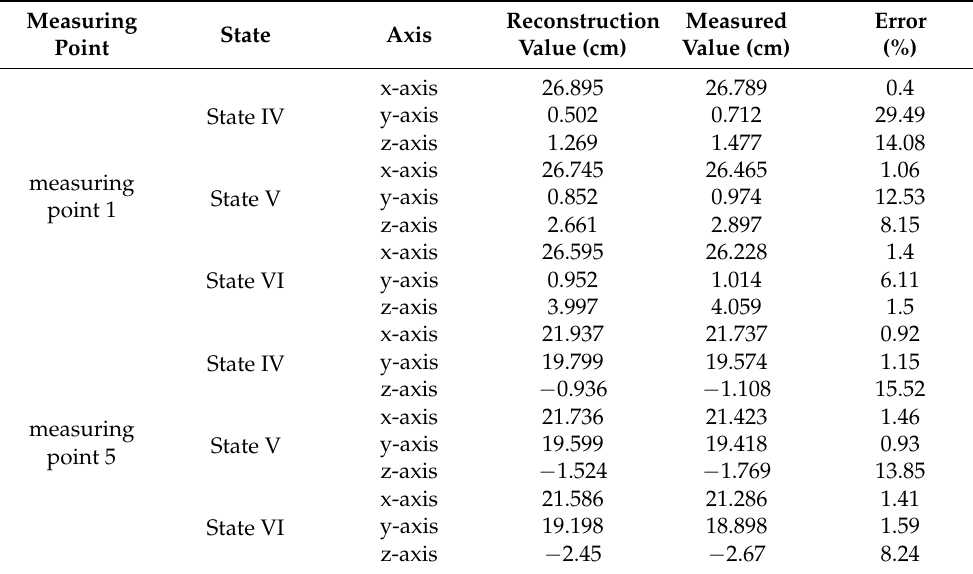
Table 6. Figure 14b comparison table of coordinate values of measuring